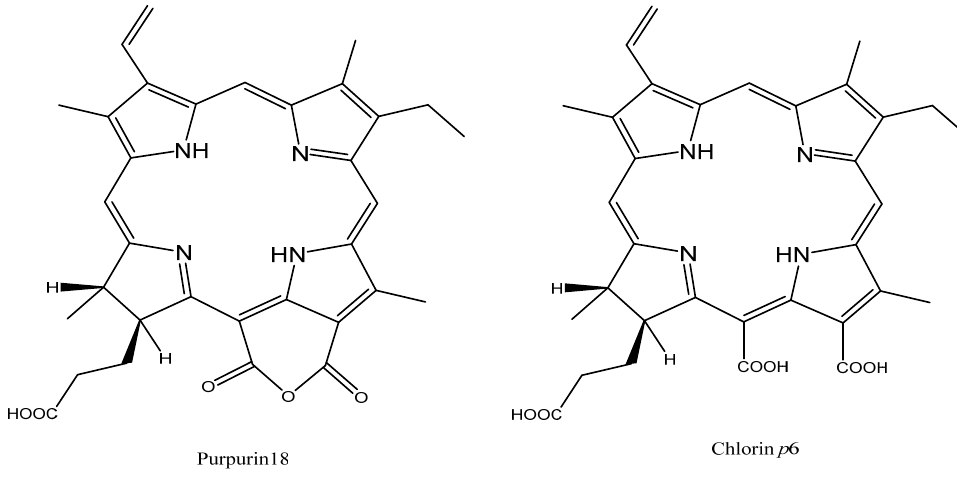
Figure 13. Chemical structure of purpurin 18 and chlorin p6 .